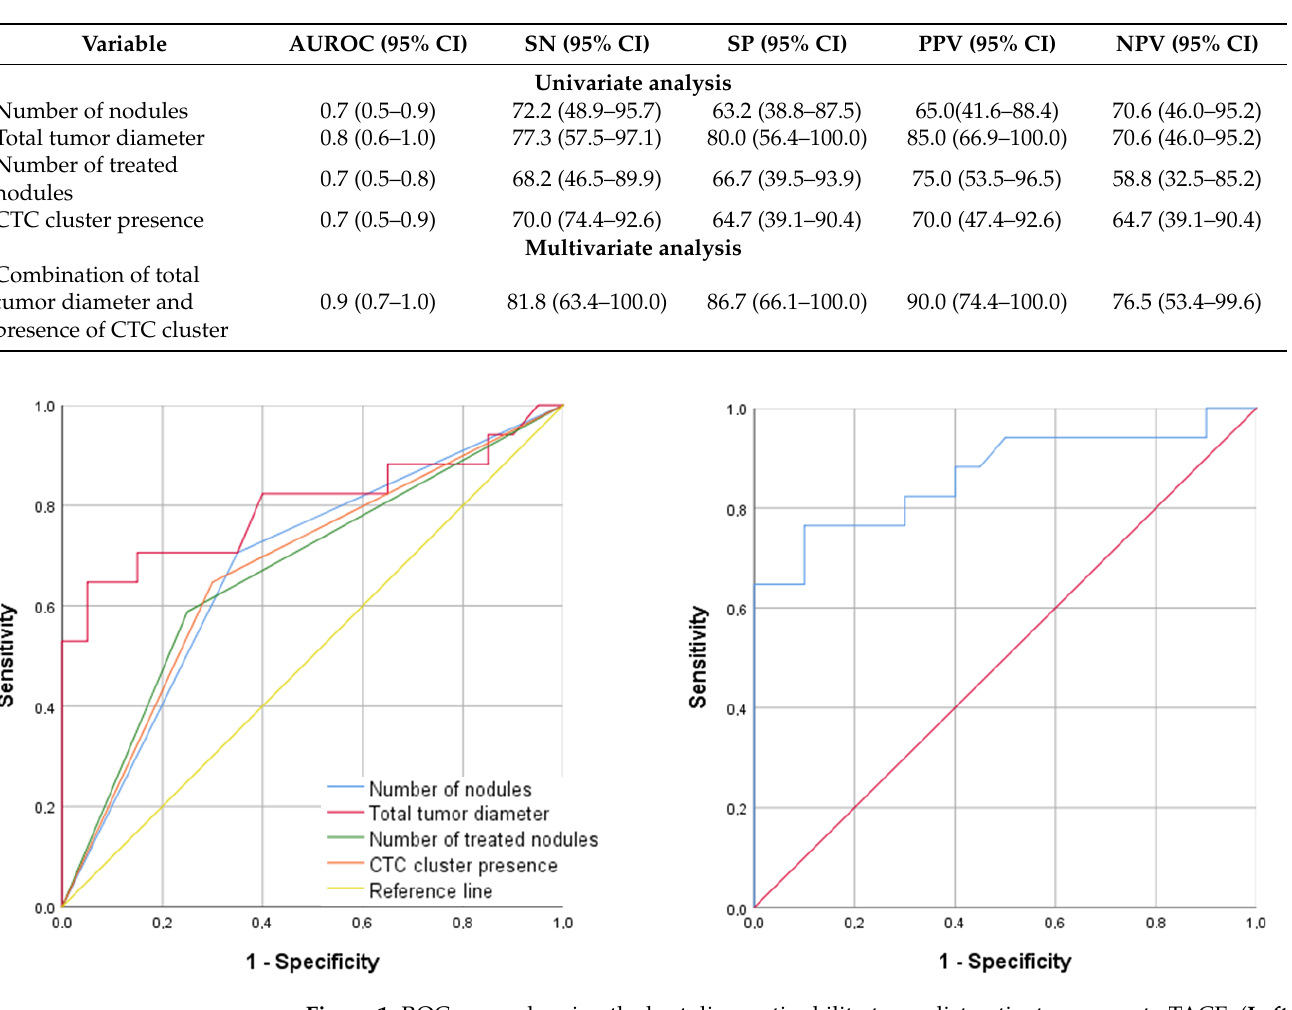
Table 4. Area under receiver operating characteristic curve (AUROC), sensitivity (SN), specificity (SP), and positive (PPV) and negative (NPV) predictive values of the univariate and multivariate models in Figure 1.